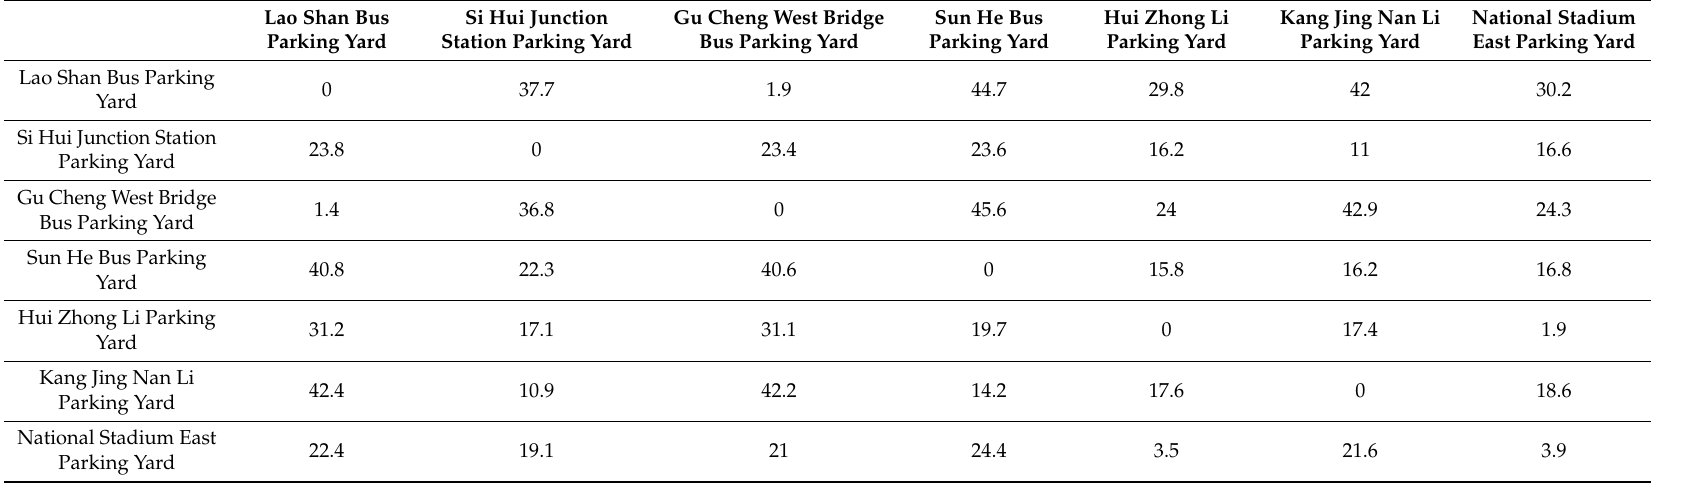
Table 4. Empty driving distance between di ff erent parking